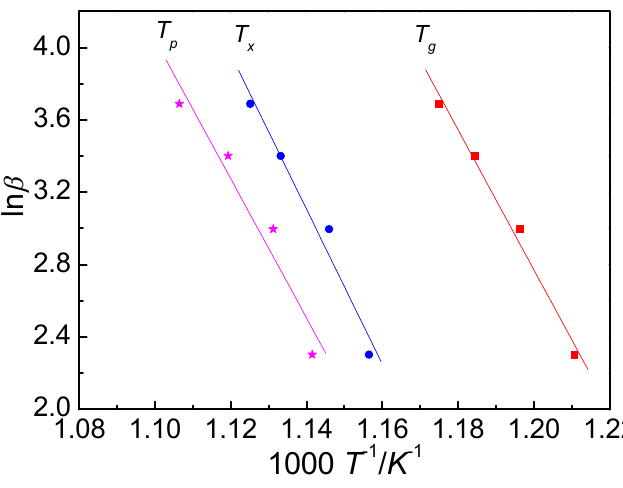
Figure 4. Ozawa plots of the Fe 68 Nb 6 B 23 Mo 3 glassy alloys.